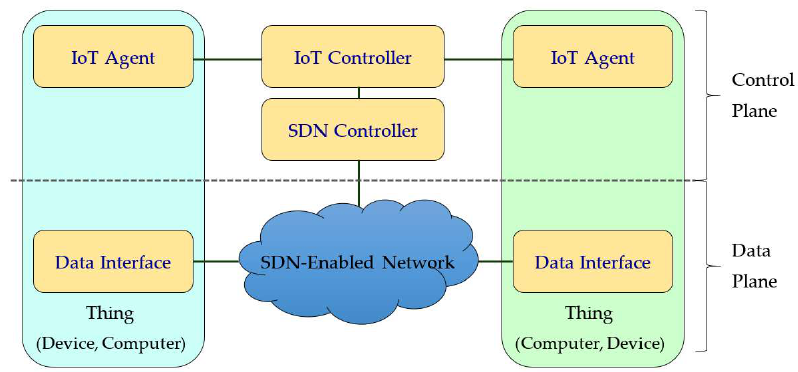
Figure 10. IoT and SDN Conceptual Integration Overview. Adapted from [74].